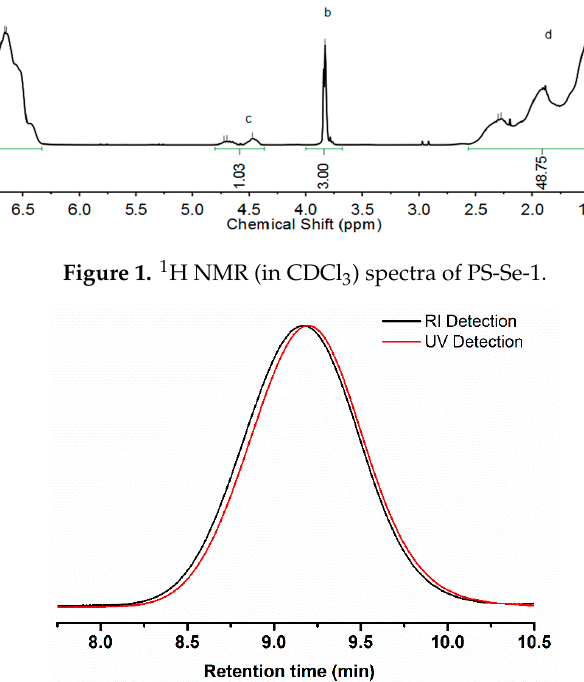
Figure 2. SEC curves of PS-Se-1 ( M n , SEC = 1900 g mol − 1 , Ð = 1.20) measured by RI and UV detection at the wavelength of 340 nm.